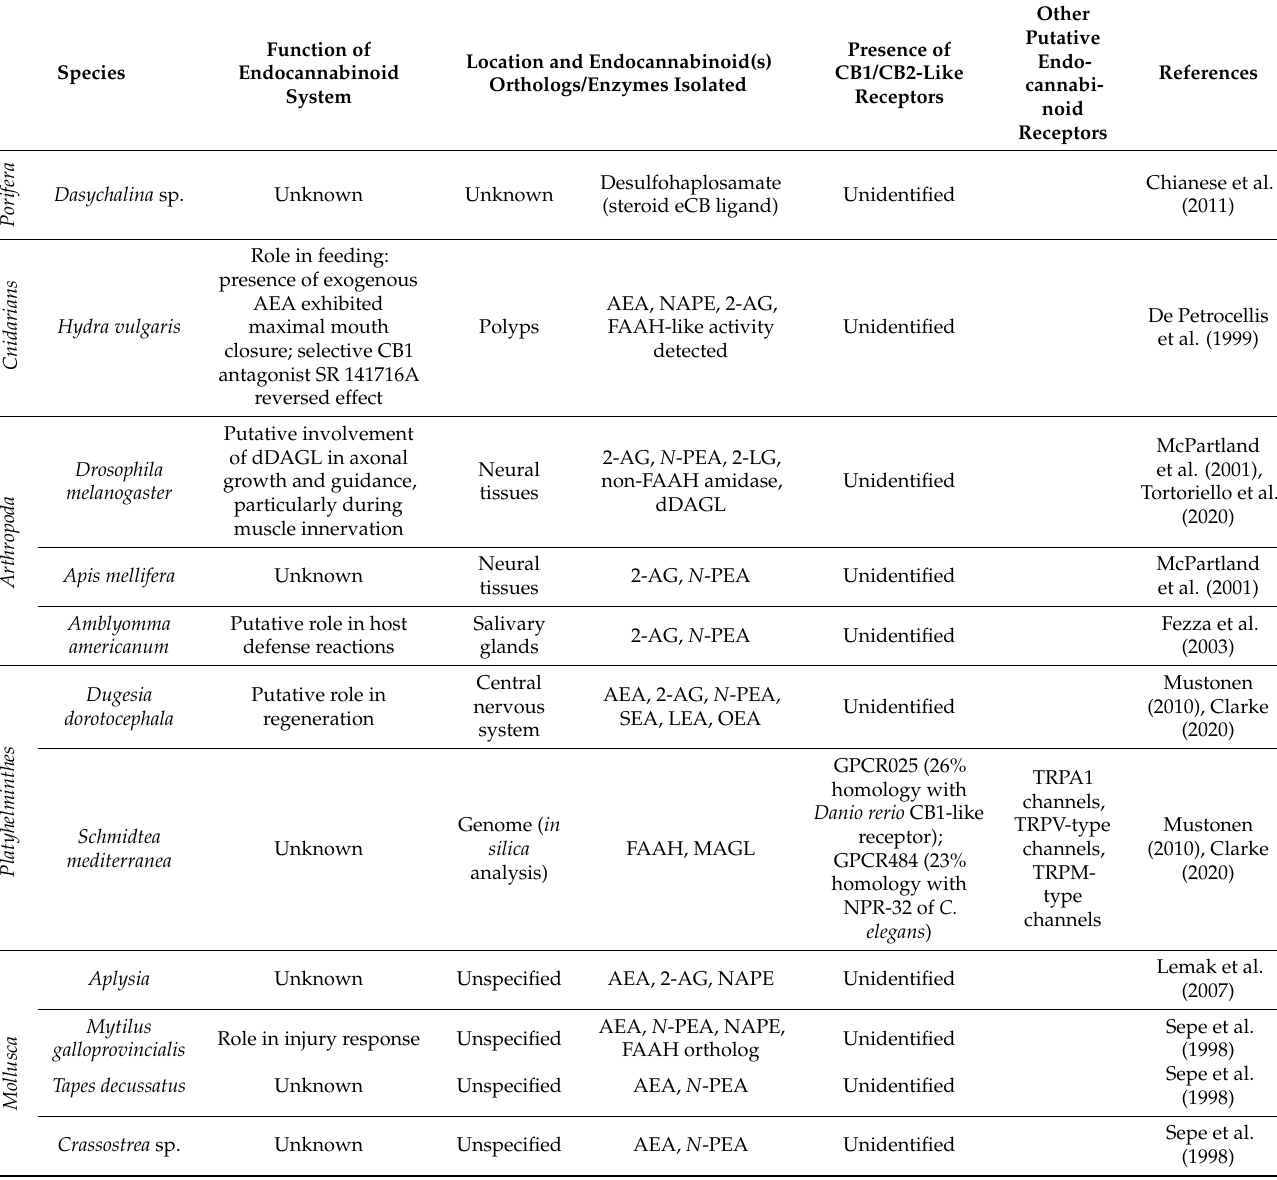
Table 1. Summary of the Endocannabinoid System in the